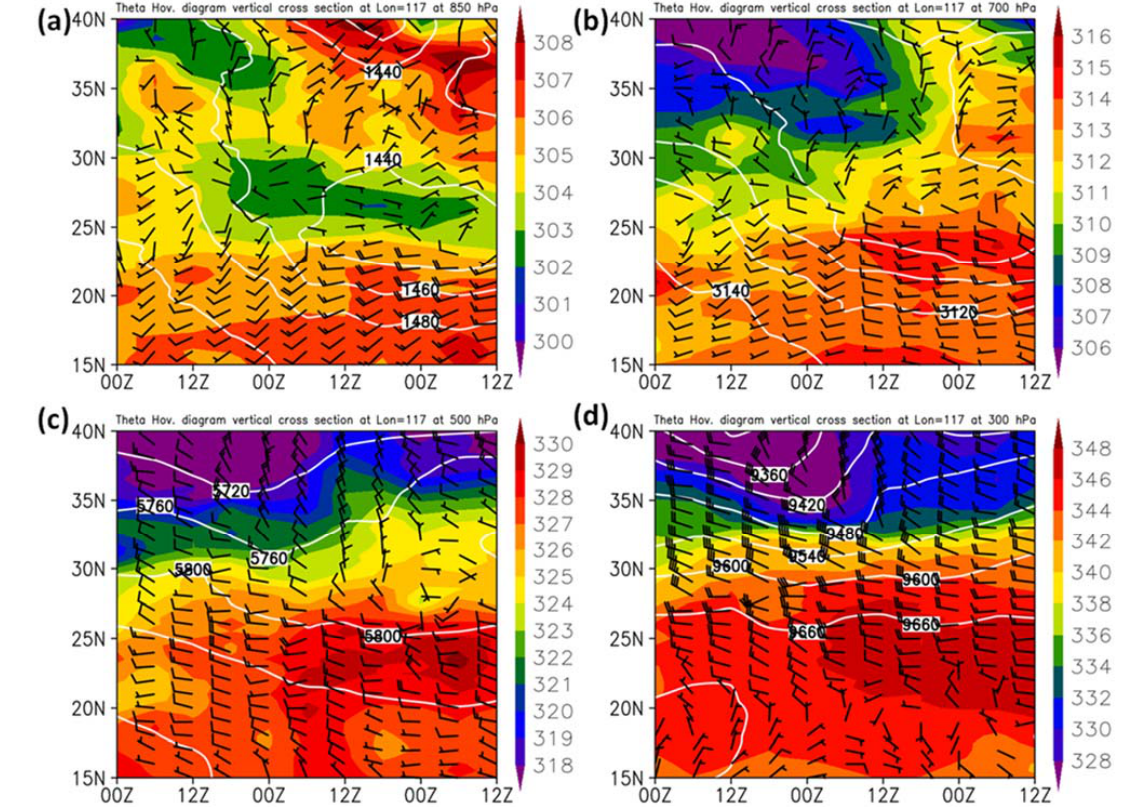
Figure 5. The CFSR latitude–time cross-section along 117 ◦ E for winds (V; m s − 1 , full barb and half barb represent 10 and 5 m s − 1 , respectively), potential temperature (K, shaded), and geopotential height (gpm, solid white lines) from 0000 UTC 5 June to 1200 UTC 7 June at ( a ) 850 hPa; ( b ) 700 hPa; ( c ) 500 hPa; and ( d ) 300 hPa.